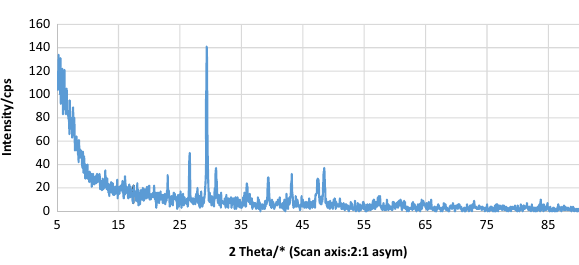
Fig. 15 XRD of the sandstone